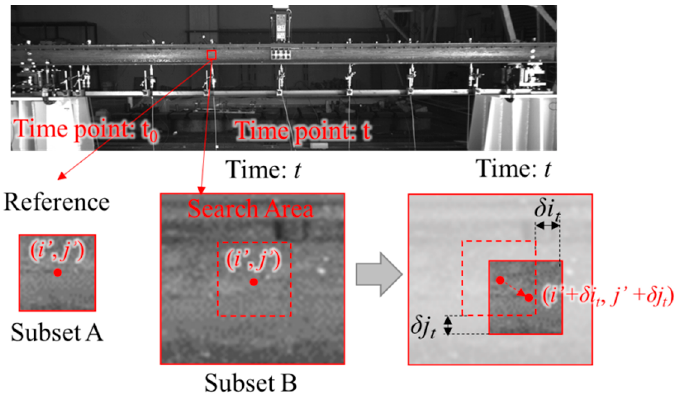
Figure 1. Digital image correlation method processing concept.